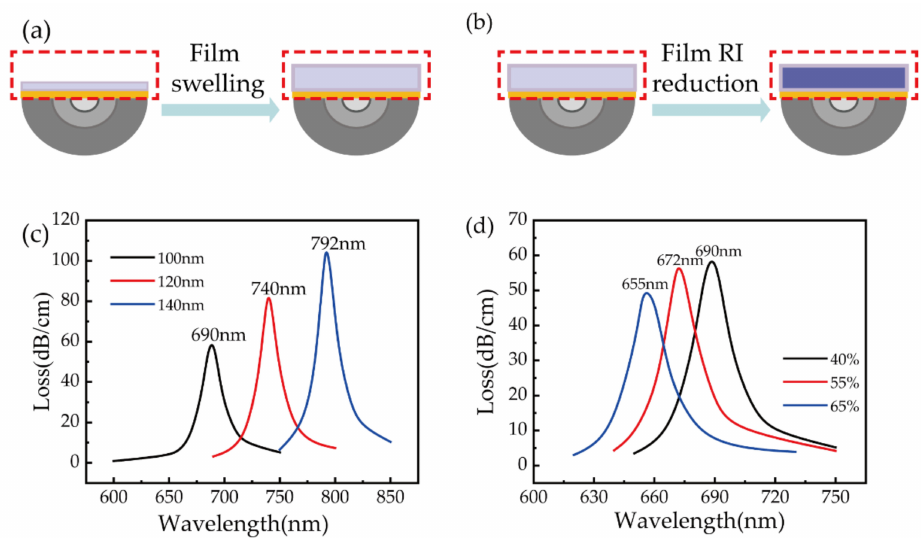
Figure 6. Schematic diagram of ( a ) PVA film swelling and ( b ) film RI reduction that cause a resonant wavelength shift of the proposed sensor. Simulated loss spectra of the RH sensor with ( c ) PVA film thickness set to 100, 120, and 140 nm and ( d ) RH of 40%, 55%, and 65%.